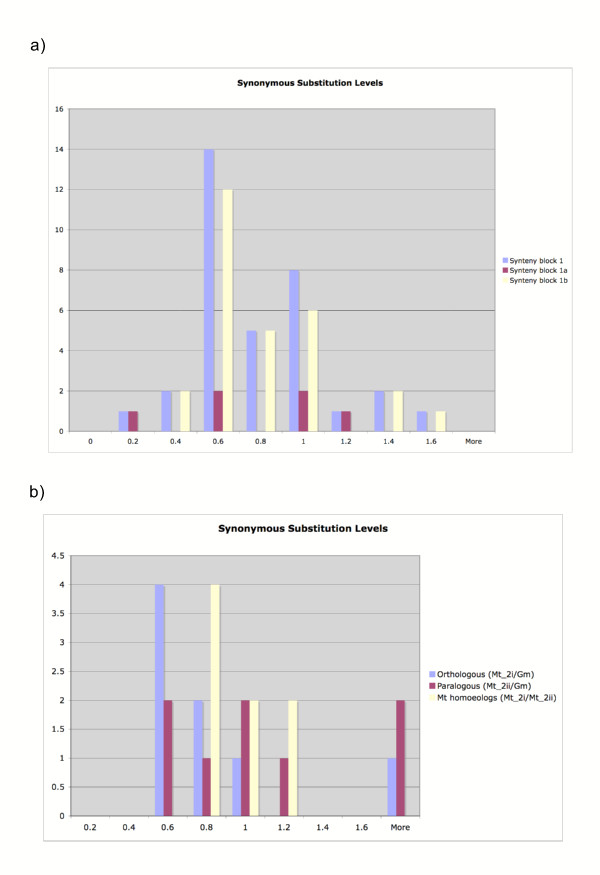
Histograms of synonymous distance between soybean and M. truncatula homologs or M. truncatula homoeologs in a) synteny block 1 and b) synteny block 2. For synteny block 2, only the 8 genes with homologs in soybean and both M. truncatula duplicates are shown.